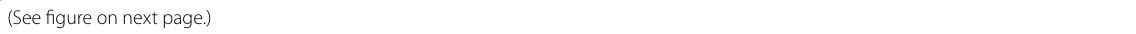
Fig. 4 Visualisation of miRNA-mRNA interaction network (EntOptLayout) and target prediction analysis (ictal vs interictal) by miRNAtarget.com ™ . Rectangle and oval-shaped nodes represent miRNAs and mRNA targets of miRNAs, respectively. The node size and colour intensity of mRNA targets change according to node strength values. Down (blue)- and upregulated (red) miRNAs, suggesting a central role of downregulated (light blue) nuclear receptor subfamily 3 group C member 1 (NR3C1) and multiple upregulated (orange) mRNAs. Whole predicted miRNA-target interaction network is shown on panel A . To highlight important mRNA targets, targets with an absolute node strength value less than or equal to 1 (i.e. -1, 0 or 1) presented uniformly smaller and fainter. On panel B , a subnetwork of the whole predicted miRNA-target interaction network is shown, containing only those target mRNAs (marked with a red oval on panel A ) and their interacting miRNAs that were validated by RNA sequencing. The same arrangement as in the whole network with a proportional magnification of the target mRNAs